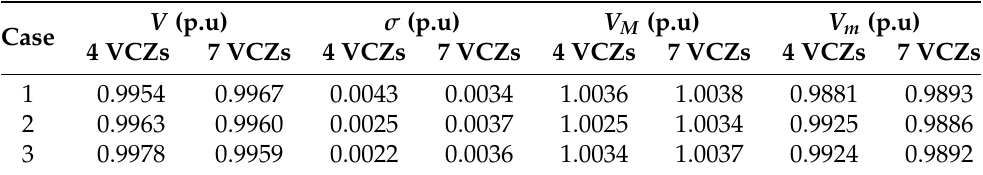
Table 7. Statistical parameters of the distribution of the nodal voltage amplitudes for the partitioning in four VCZs and seven VCZs provided by solving problem (3).